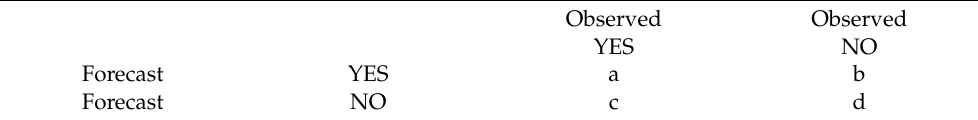
Table A1. Elements of the contingency